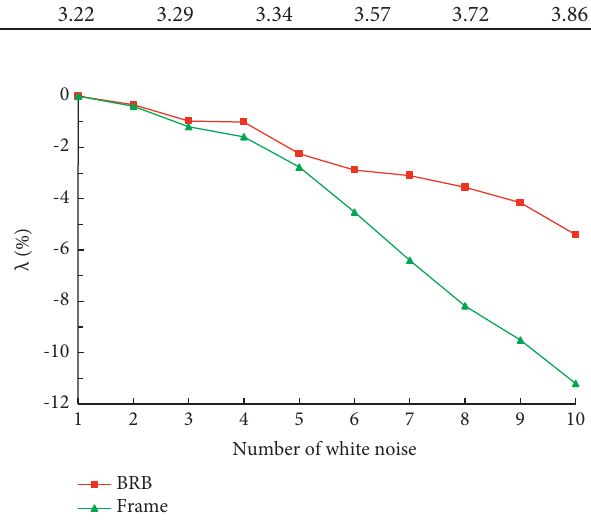
Figure 14: Stiffness degradation of the